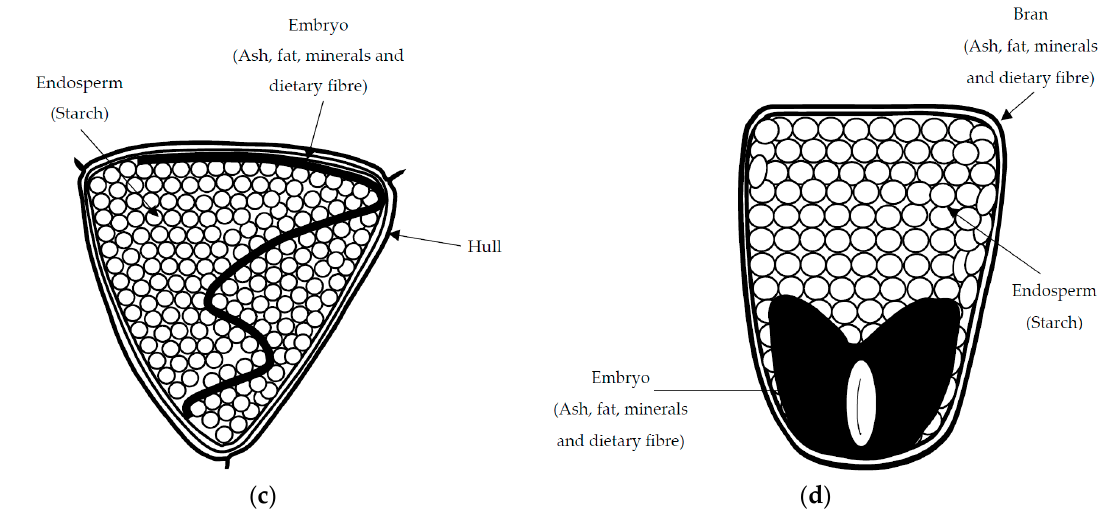
Figure 1. Schematic representation of grain structure of quinoa and amaranth ( a ); rice ( b ); buckwheat ( c ); and maize ( d ).